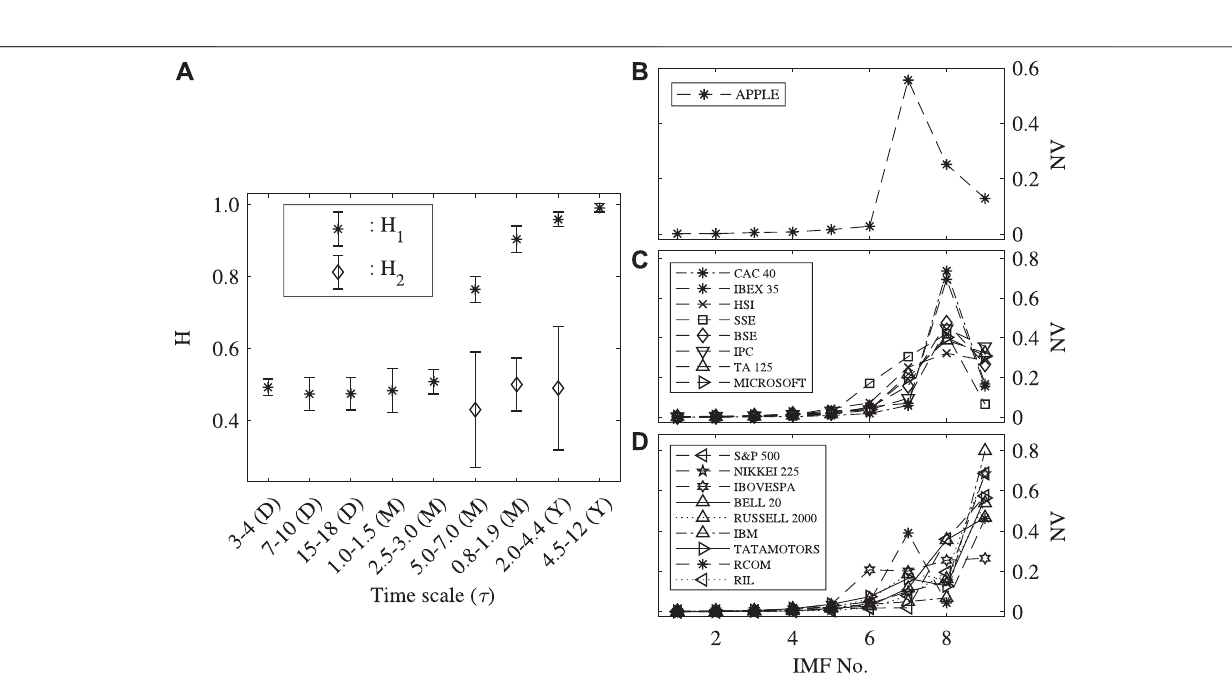
FIGURE2|(A) showstheHurstexponents( H 1 and H 2 )vs. τ ofallthe IMFs ofalltheindicesandcompanieswith2 σ errorbar.The fi rstpointrepresentstheaverage valueof